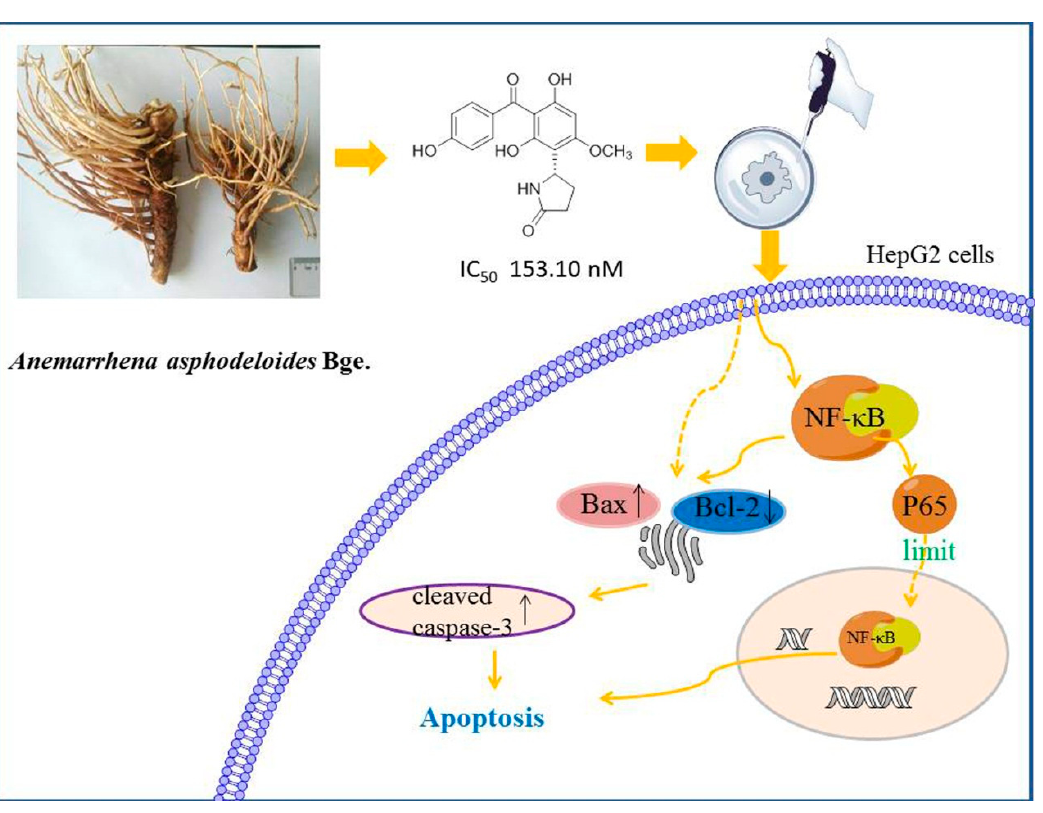
Figure 6. Schematic overview of the proposed mechanism of benzophenones from Anemarrhena asphodeloides Bge. in HepG2